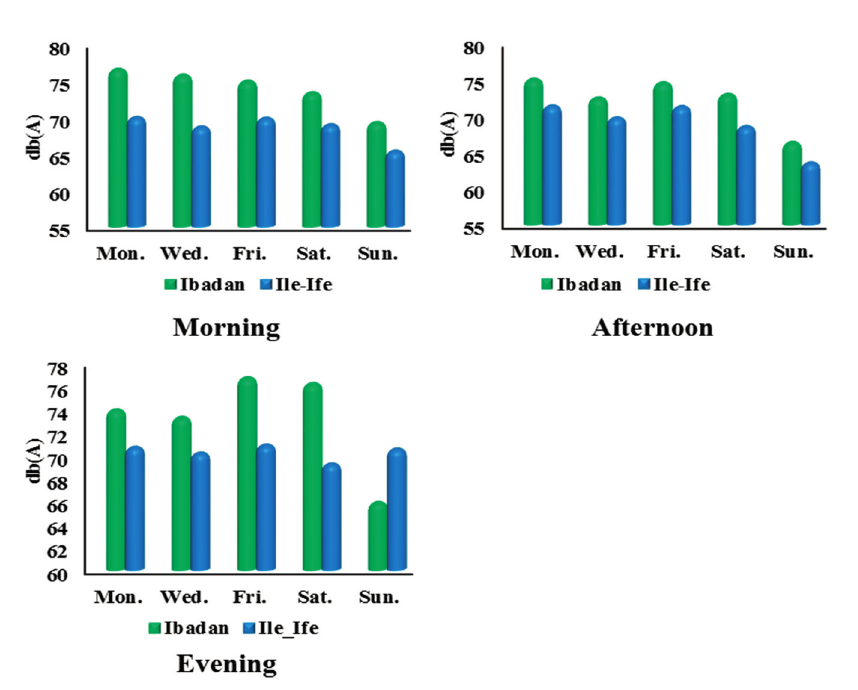
Figure 8. Mean daily noise levels in Ibadan and